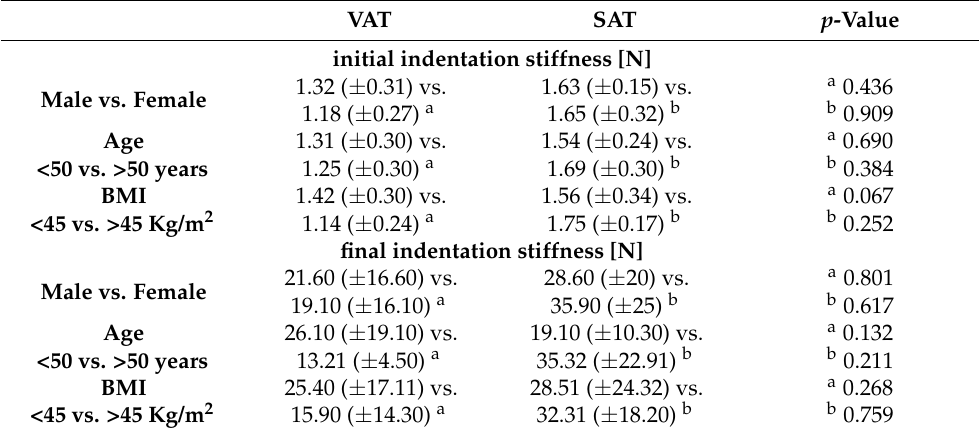
Table 2. Initial indentation stiffness and final indentation stiffness for VAT and SAT in relation to gender, BMI, and age.